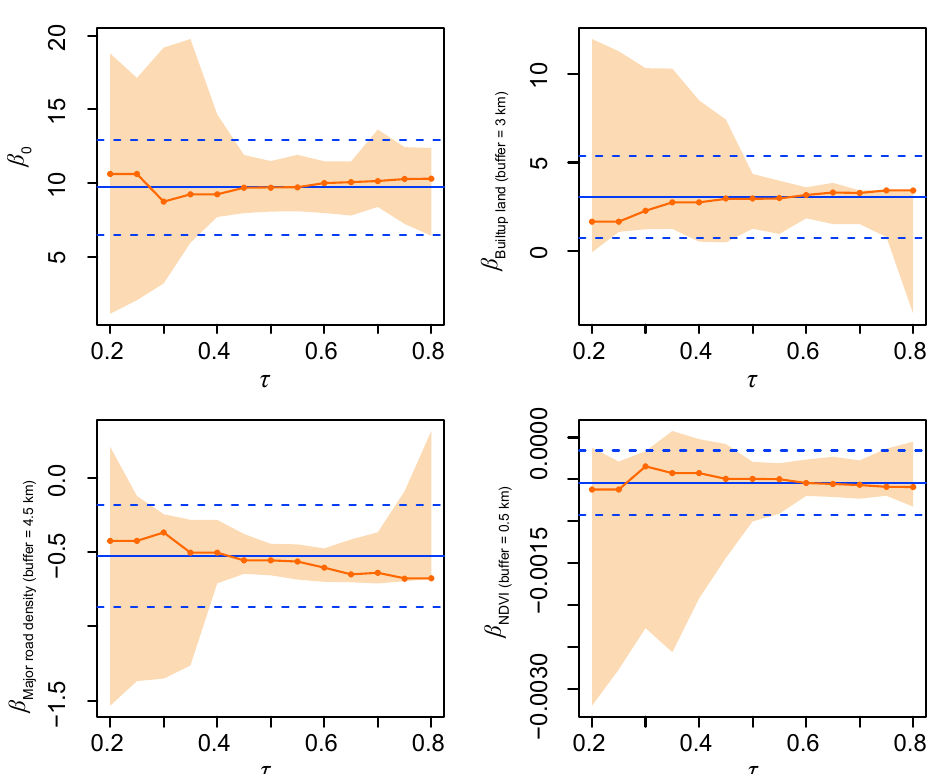
Figure 3. Coefficients of explanatory variables in the land use quantile regression (LUQR) model for PM 2.5 prediction. The orange lines are coefficients by quantiles in LUQR model, and orange areas show the 95% CIs of LUQR coefficients. The blue horizontal lines are coefficients of the linear regression model, and the blue dashed lines are the 95% confidence intervals (CIs) of the coefficients in the linear regression model.